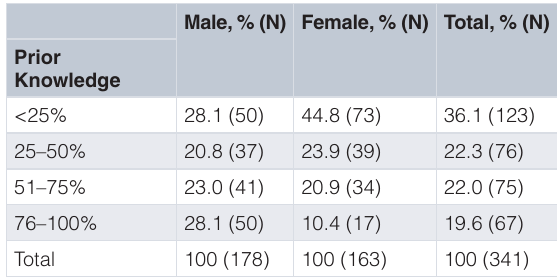
Table 1. Distributions of respondents who agreed or strongly agreed to the “knowledge gained” question, by gender and self-reported prior